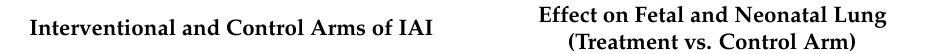
Table 3. Examples of promising strategies to prevent or treat prenatal infection-induced lung injury in preclinical rodent and sheep models in the last 5